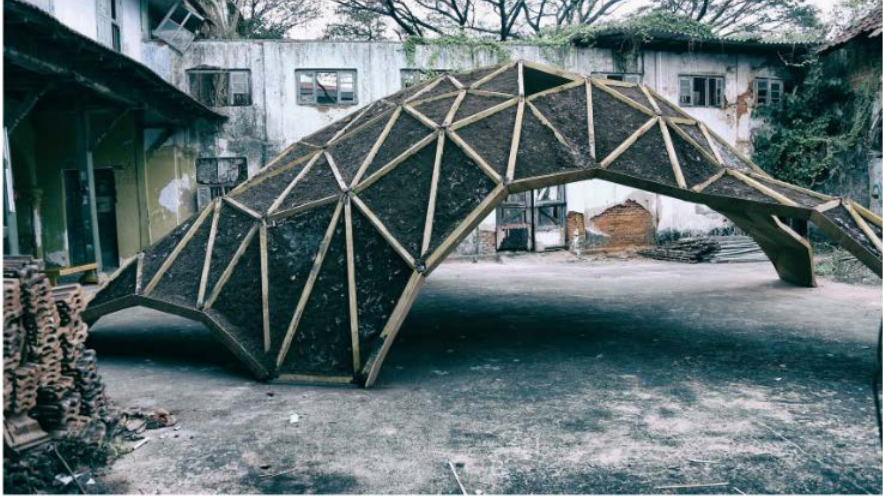
Figure 10 Shell Mycelium Pavilion-2016